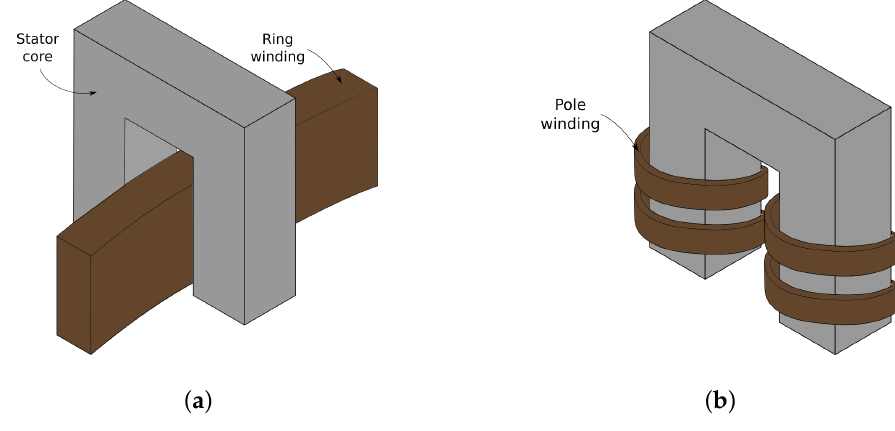
Figure 10. ( a ) Ring winding, ( b ) pole winding of a